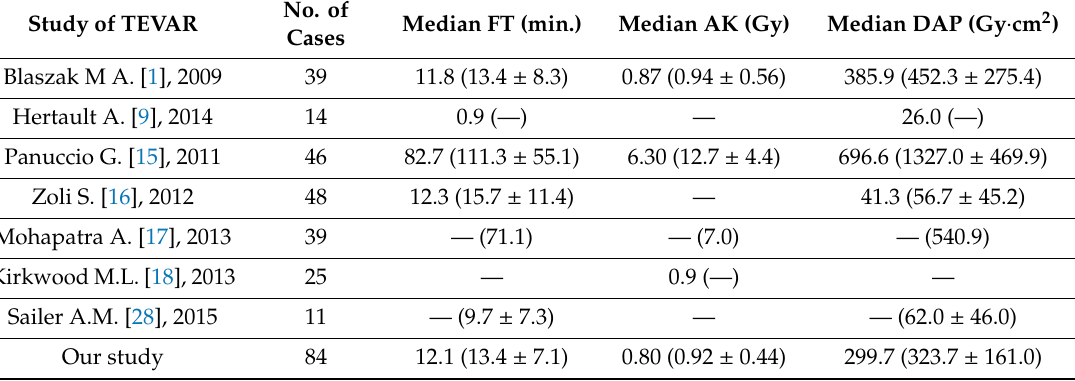
Table 4. Overview of reports describing the endovascular treatment of thoracic aortic aneurysms (TEVAR) in HORSs.